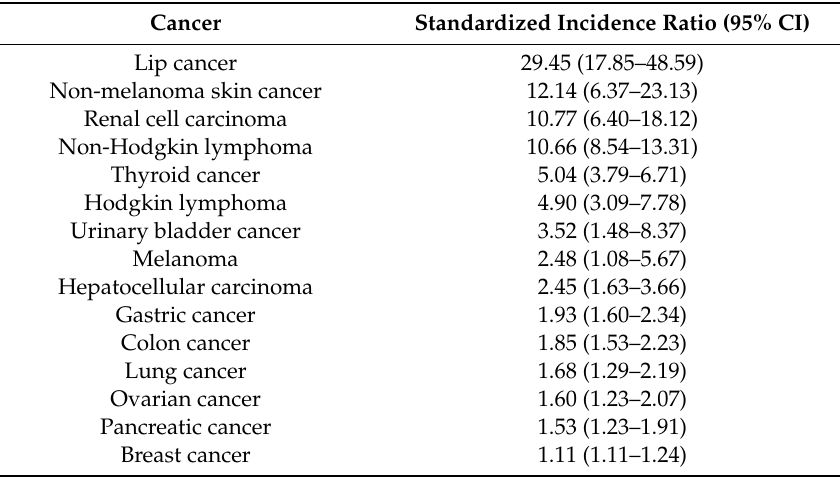
Table 2. Standardized incidence ratio of cancers in kidney transplant recipients